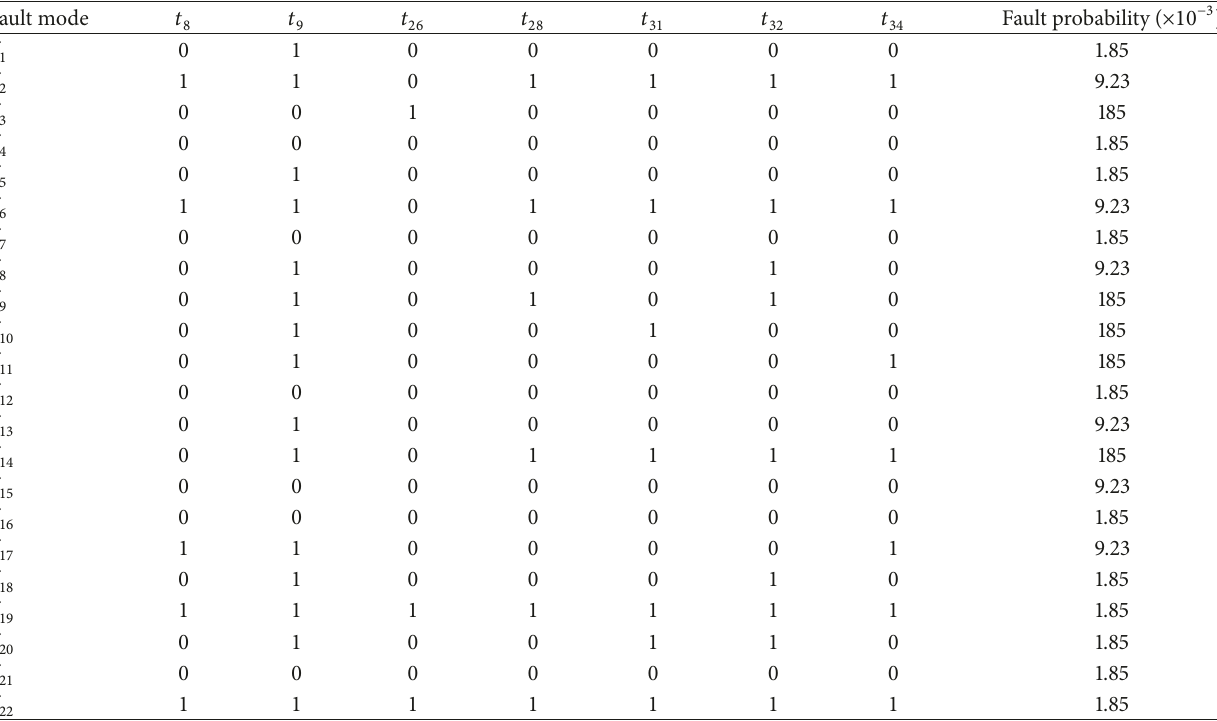
Table 2: The testability indicators for the superheterodyne receiver.